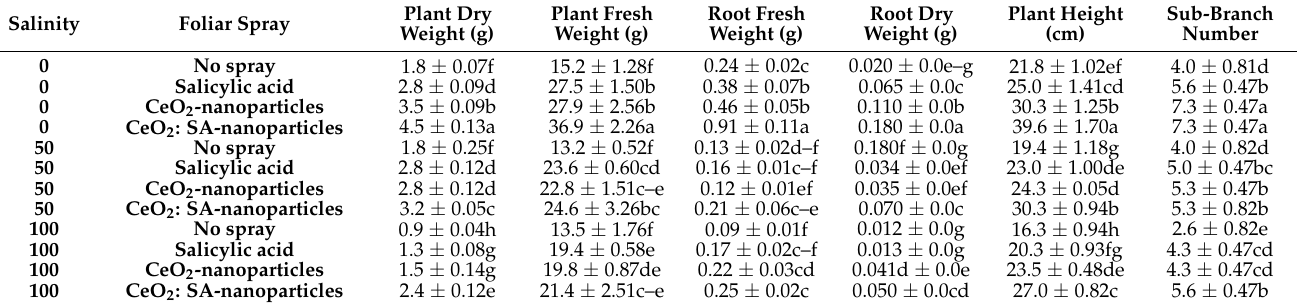
Table 2. Comparison of means for the effects of salinity (0–50 and 100 mM NaCl) and foliar applications (no spray, salicylic acid, CeO 2 -nanoparticles, and CeO 2 :SA-nanoparticles) on the growth characteristics of Portulaca oleracea